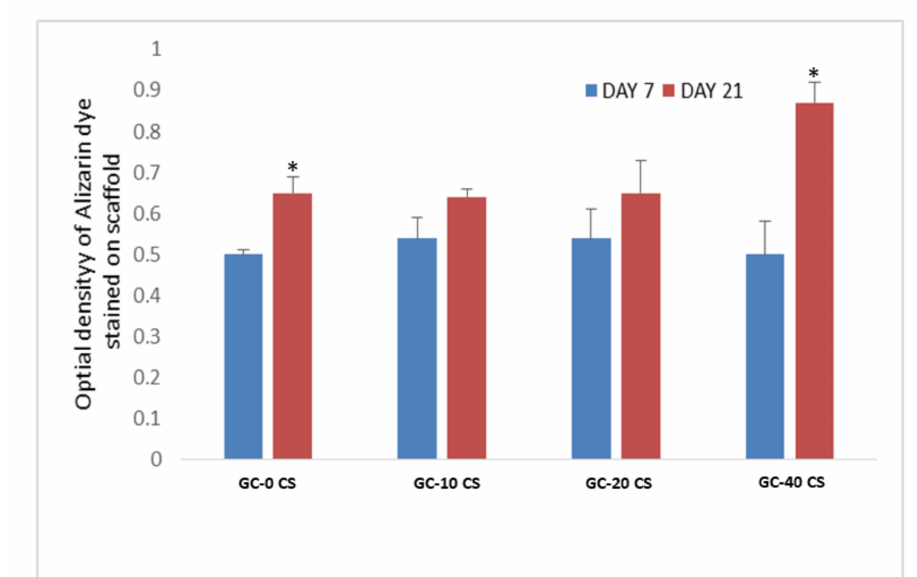
Figure 7. Alizarin-Red staining of hBMSCs seeded in GC-0 CS, GC-10 CS, GC-20 CS, and GC-40 CS scaffolds at days 7 and 21. Statistical analyses: One-way ANOVA followed by Post-Hoc LSD test; * p < 0.05 indicates level of statistical